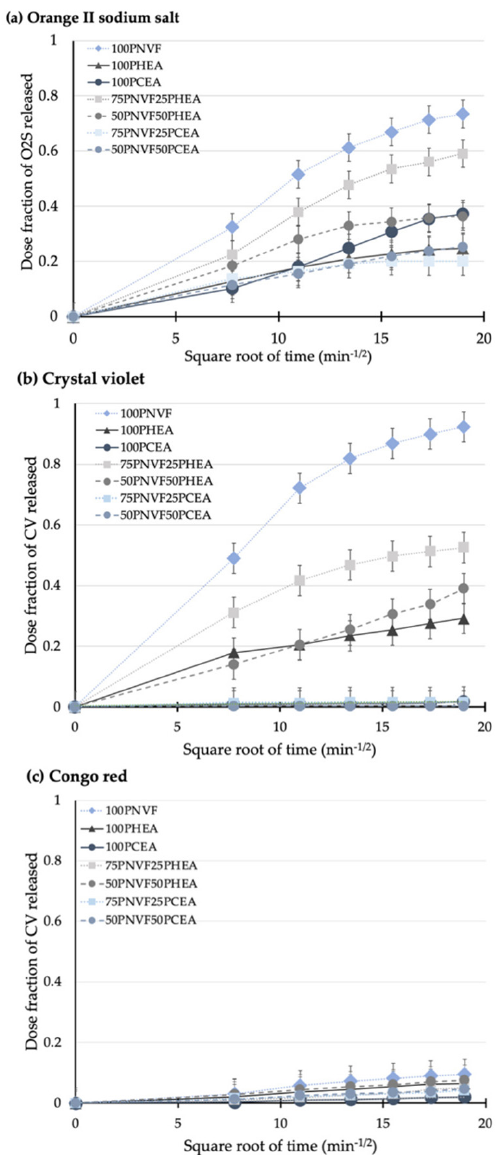
Figure 9. Release profiles of the hydrogel samples with dose fraction plotted vs. square root of time for ( a ) orange II sodium salt, ( b ) crystal violet, and ( c ) Congo red.